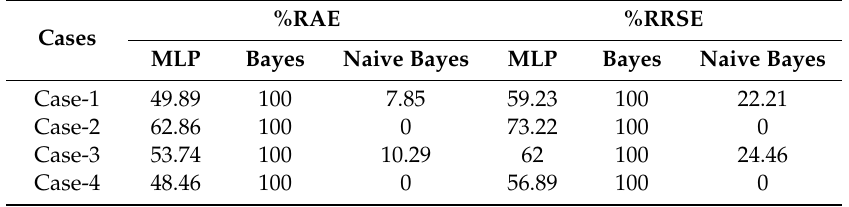
Table 11. Performance comparison with literature